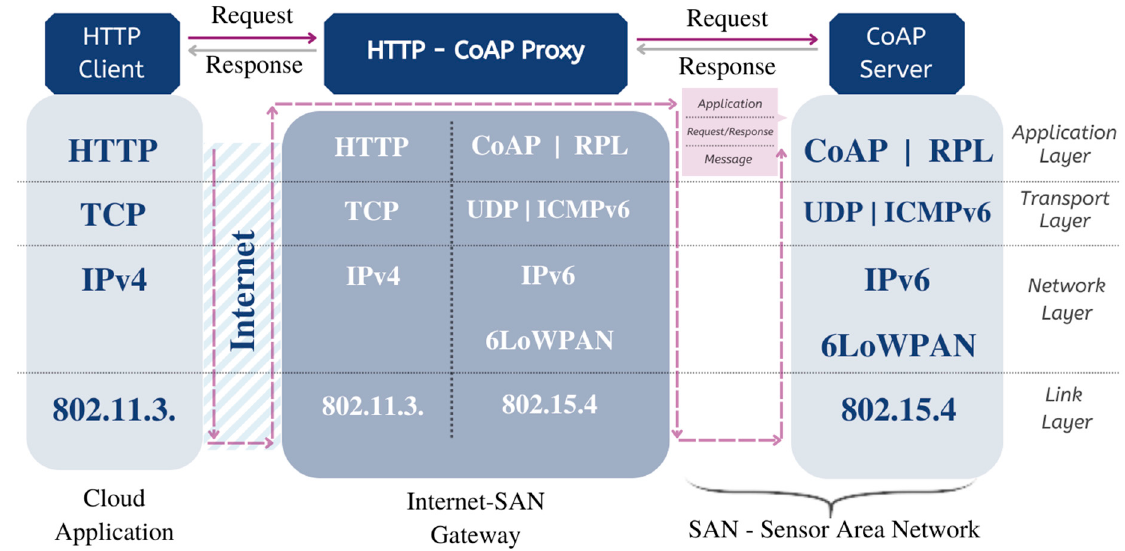
Figure 15. HTTP client and CoAP server interactions by layer via the HTTP-CoAP proxy.